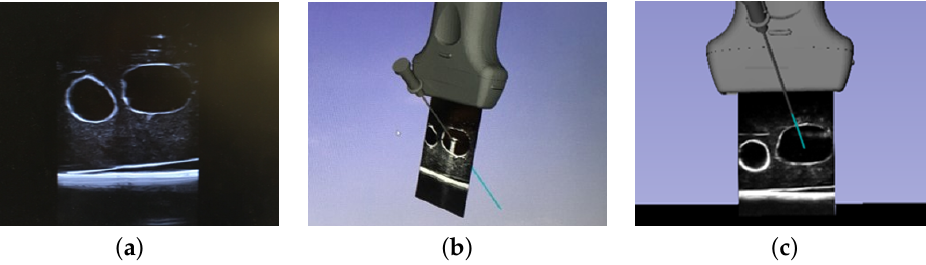
Figure 4. Visual representations of each mode of visualization where ( a ) is the US-only system, ( b ) is the monitor system, and ( c ) is the HMD system. Images ( b , c ) comprise models of the US probe, needle, needle trajectory, and the calibrated US